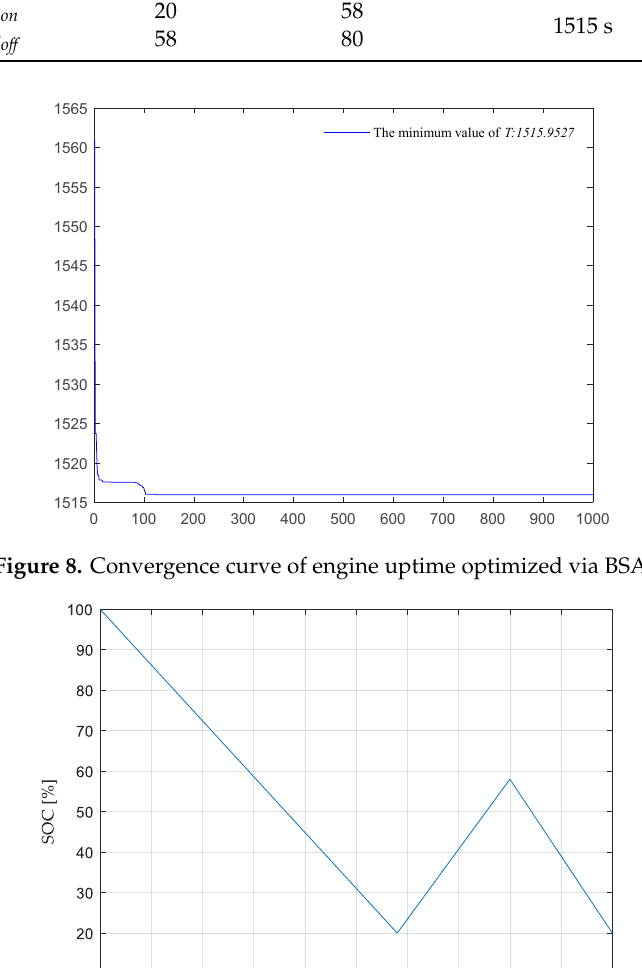
193 Figure 10. Convergence curve of t optimized with BSAII.